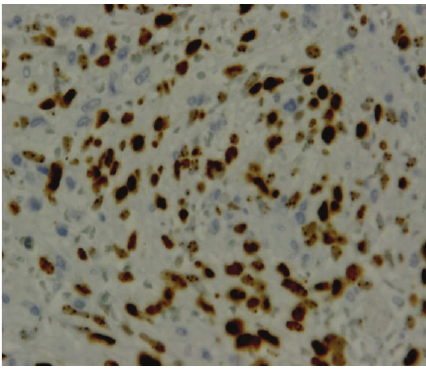
Figure 5: (400x). Picture that shows the nuclear human herpes 8